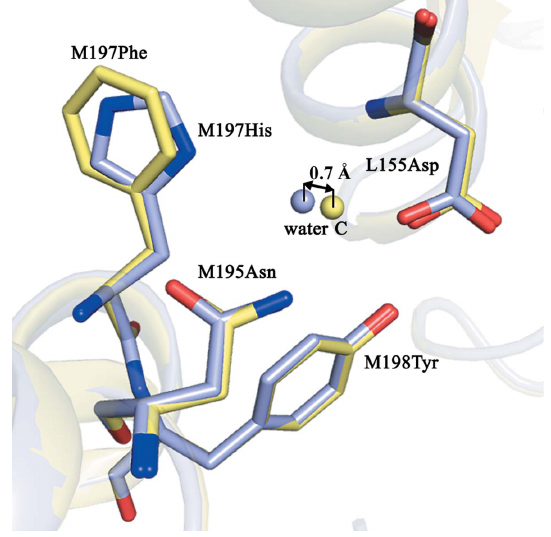
Figure 5 Superimposition of the structural models of the WT RC (pale yellow) and F(M197)H RC (light blue).